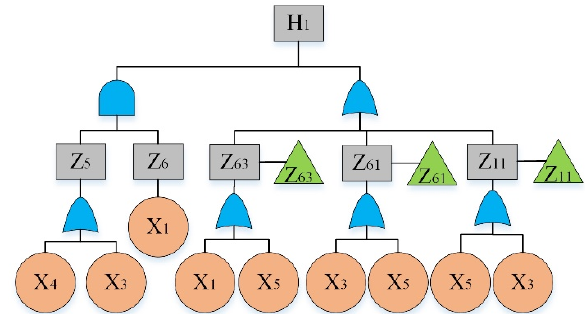
Figure 2. Fault tree of a hydraulic system: main tree.